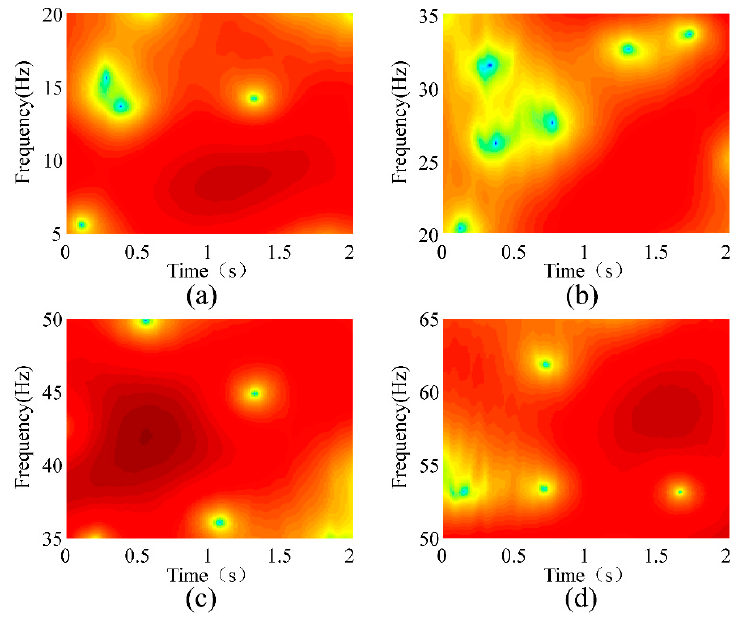
Figure 12. Short-time Fourier transform (STFT) analysis of the conductor’s vibration responses at a wind velocity of 1.5 m/s. ( a ) 1st Mode; ( b ) 2nd Mode; ( c ) 3rd Mode; ( d ) 4th Mode.